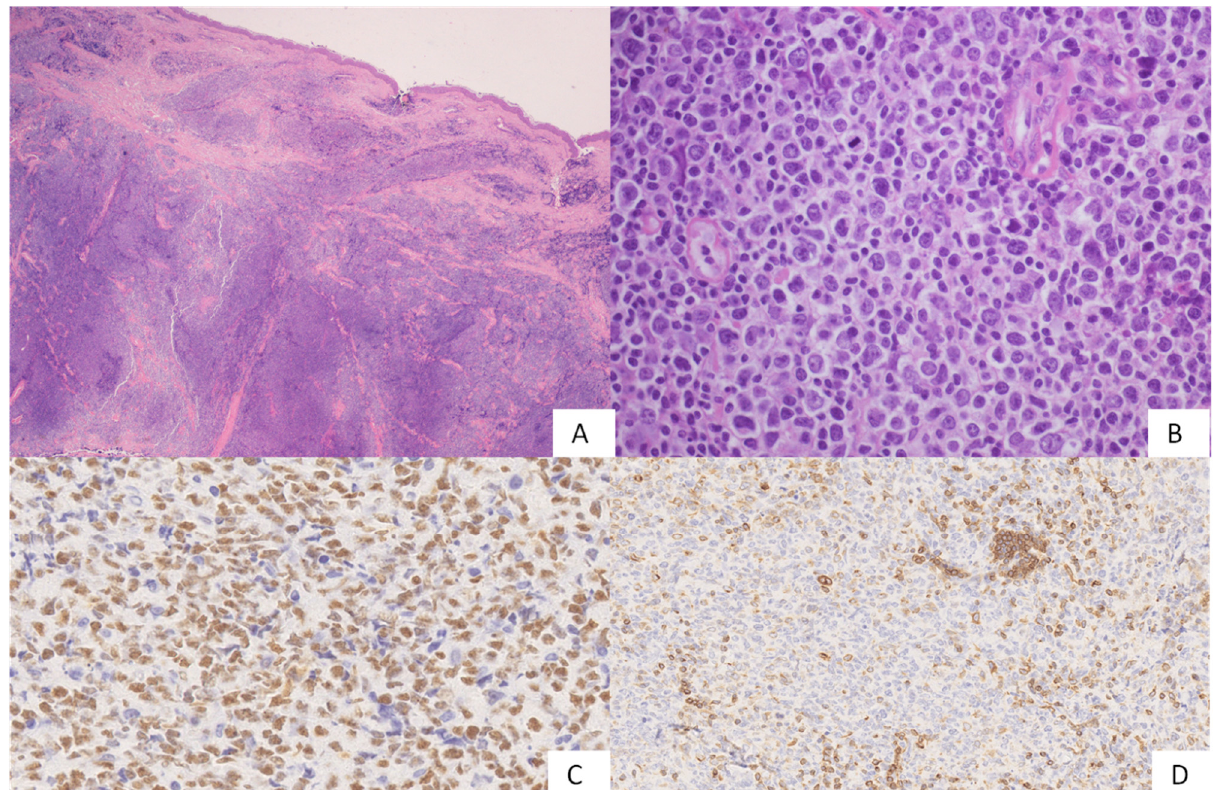
Figure 4. PCDLBCL ‐ NOS. At histological evaluation, this lymphoma shows a diffuse growth Figure 4. PCDLBCL-NOS. At histological evaluation, this lymphoma shows a diffuse growth pattern, pattern, sometimes with vaguely nodular areas (( A ), HE 2×) and is composed of large centroblasts sometimes with vaguely nodular areas (( A ), HE 2 × ) and is composed of large centroblasts with with a minority of medium ‐ sized cells (( B ) , HE 40×). PCDLBCL ‐ NOS is frequently bcl6 ‐ positive a minority of medium-sized cells (( B ), HE 40 × ). PCDLBCL-NOS is frequently bcl6-positive (( C ), 40 × ) (( C ), 40×) and bcl ‐ 2 ‐ negative (( D ), 20×). and bcl-2-negative (( D ), 20 ×